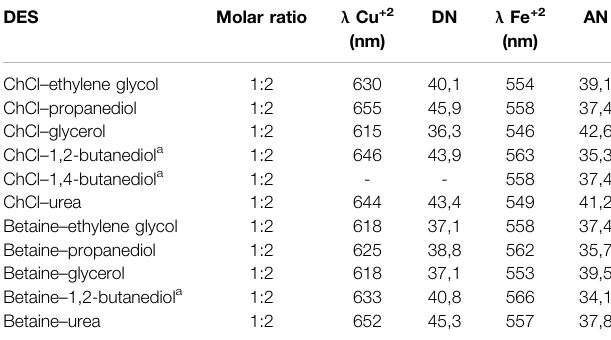
TABLE 3 | Absorption maxima ofsolvatochromic dyes and the corresponding AN and DN associated with DES at their eutectic ratio at 25 ° C. DES Molar